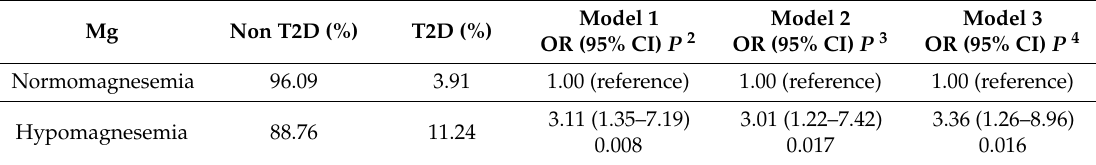
Table 4. Association between hypomagnesemia 1 and prevalence of type-2